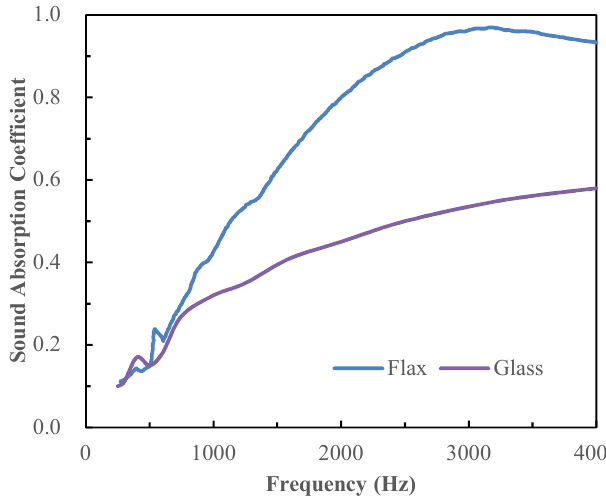
Figure 5. The experimental sound absorption coefficients of unidirectional flax and glass fiber fabrics with frequency.